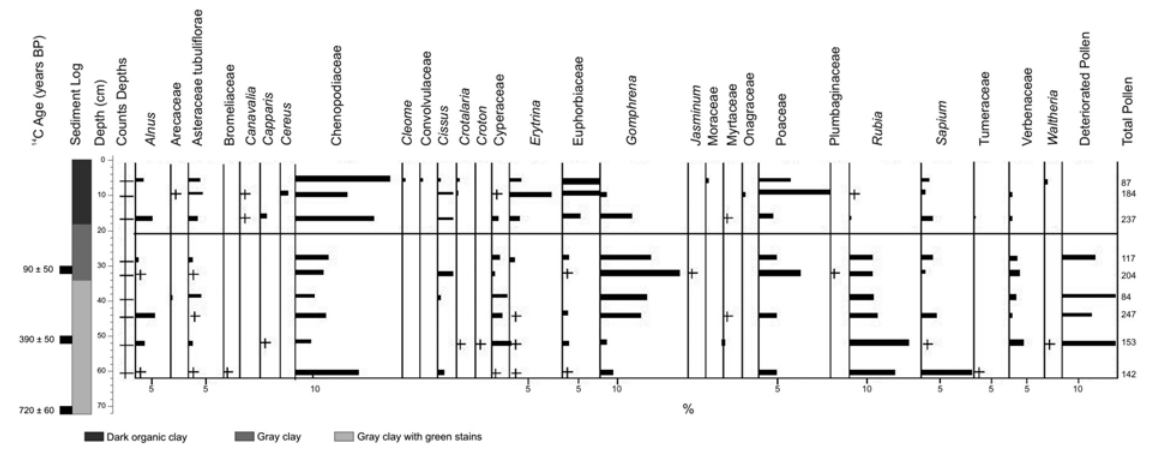
Fig. 4 – Pollen percentage diagram of Lagoa da Viração showing selected taxa. The pollen sum includes arboreal and non-arboreal pollen taxa. Values smaller than 1% are represented by the “ + ”